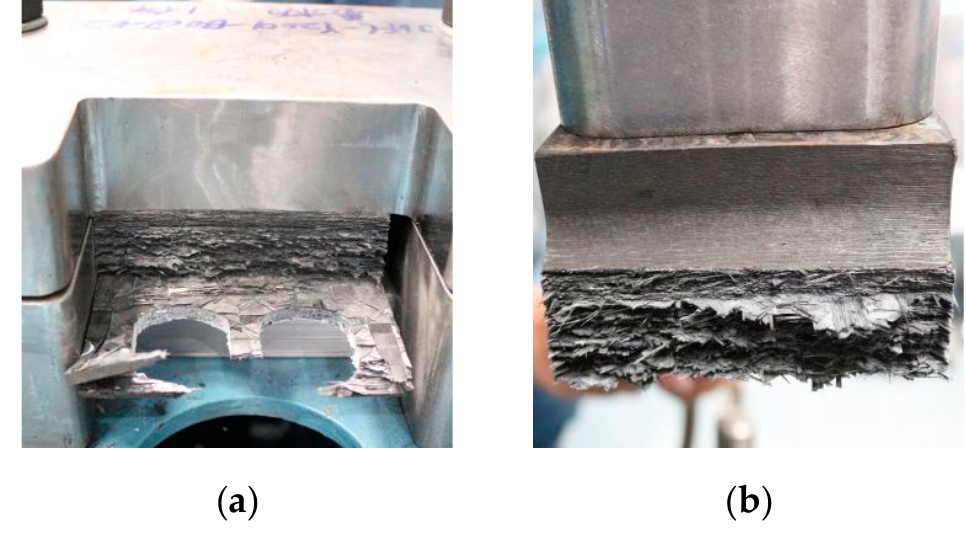
Figure 11. Fiber damage status ( a , b ).